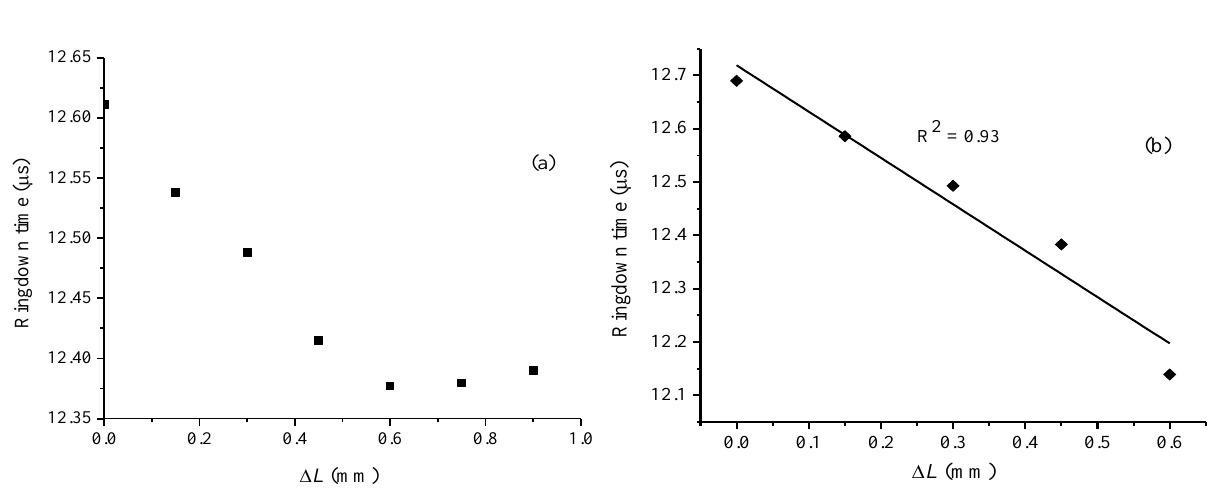
Figure 2. ( a ) A graph of the ringdown time versus the stretched length (Δ L ) from the fiber stretch experiment; upto the breaking threshold of the fiber. ( b ) Result from the repeated fiber stretch